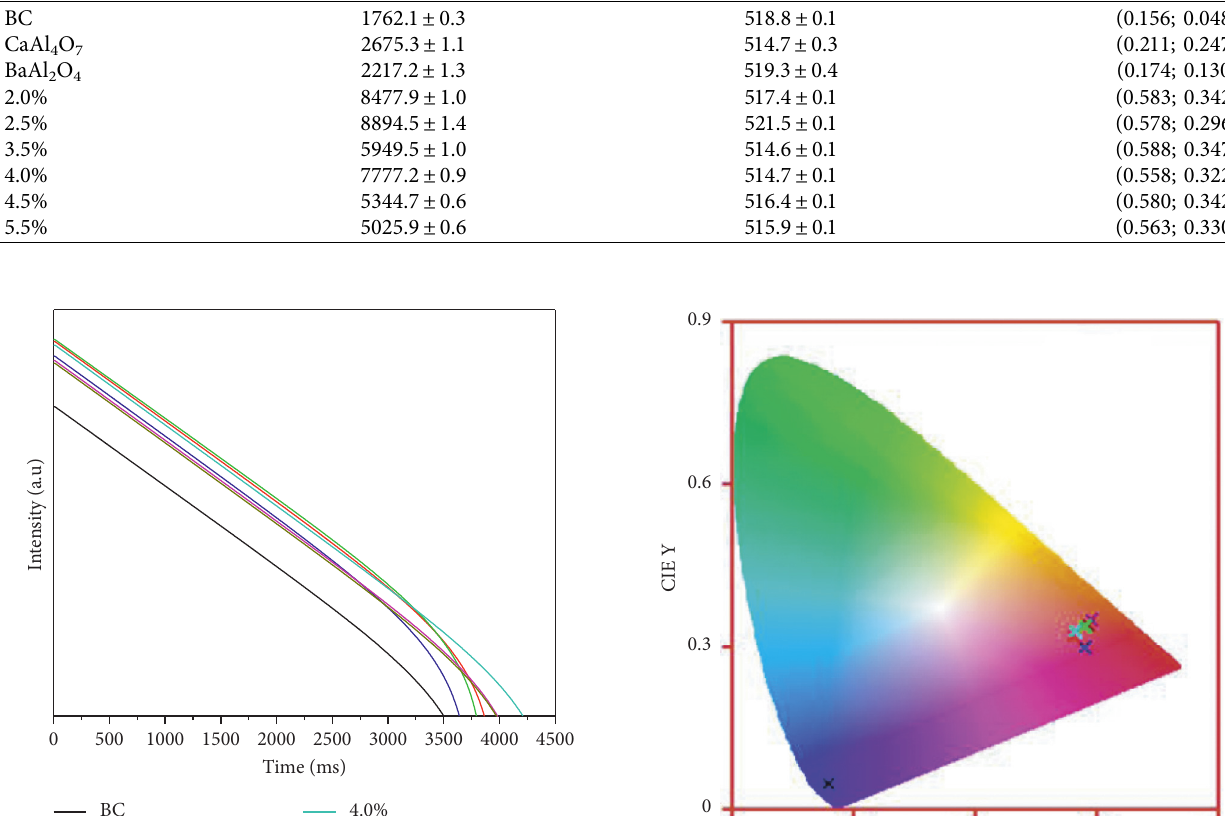
Table 3: Kinetic analysis results and CIE ( x ; y ) coordinates for BaAl Samples